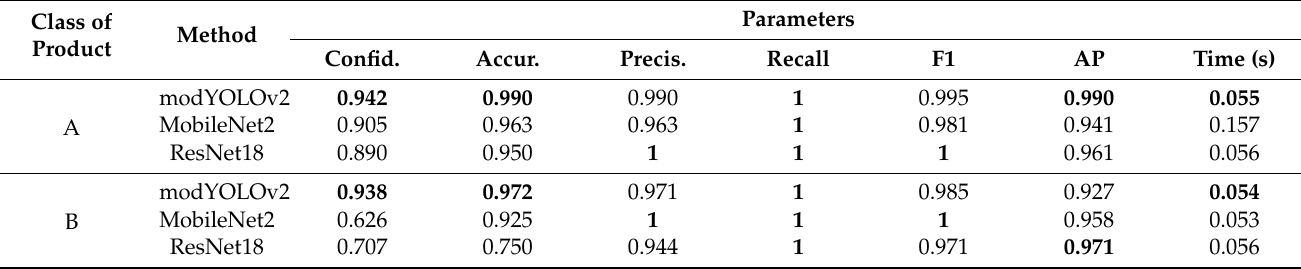
Table 3. Grasping evaluation of detection using a modified YOLOv2 and another